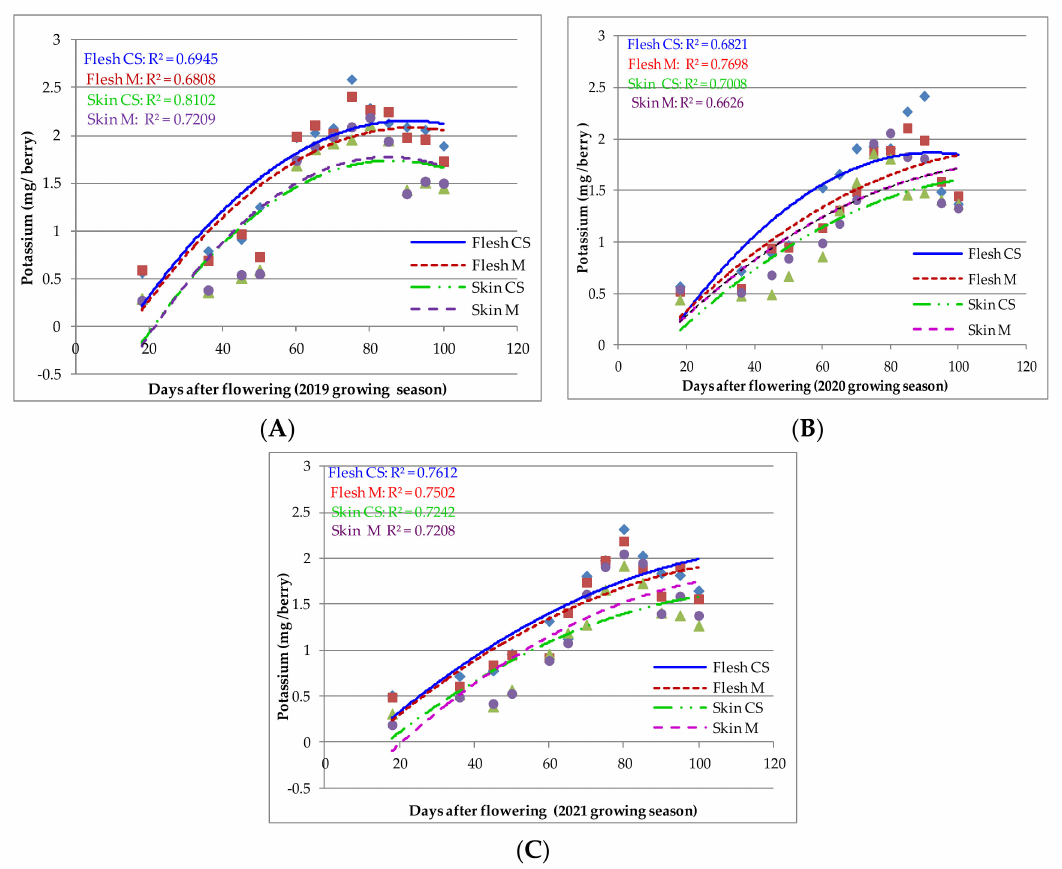
Figure 2. K accumulation in ‘Cabernet Sauvignon’ (CS) and ‘Merlot’ (M) berry skin and flesh during 2019–2021 growing seasons ( A – C ) from flowering to maturity. A scatterplot with a trend line of different colour and dash type was drawn to represent the relationships between DAF and K accumulation in flesh and skin for the CS and M varieties, during 2019–2021 growing seasons. The regression analysis suggests that K accumulation changes with DAF. ( —K flesh CS; —K flesh